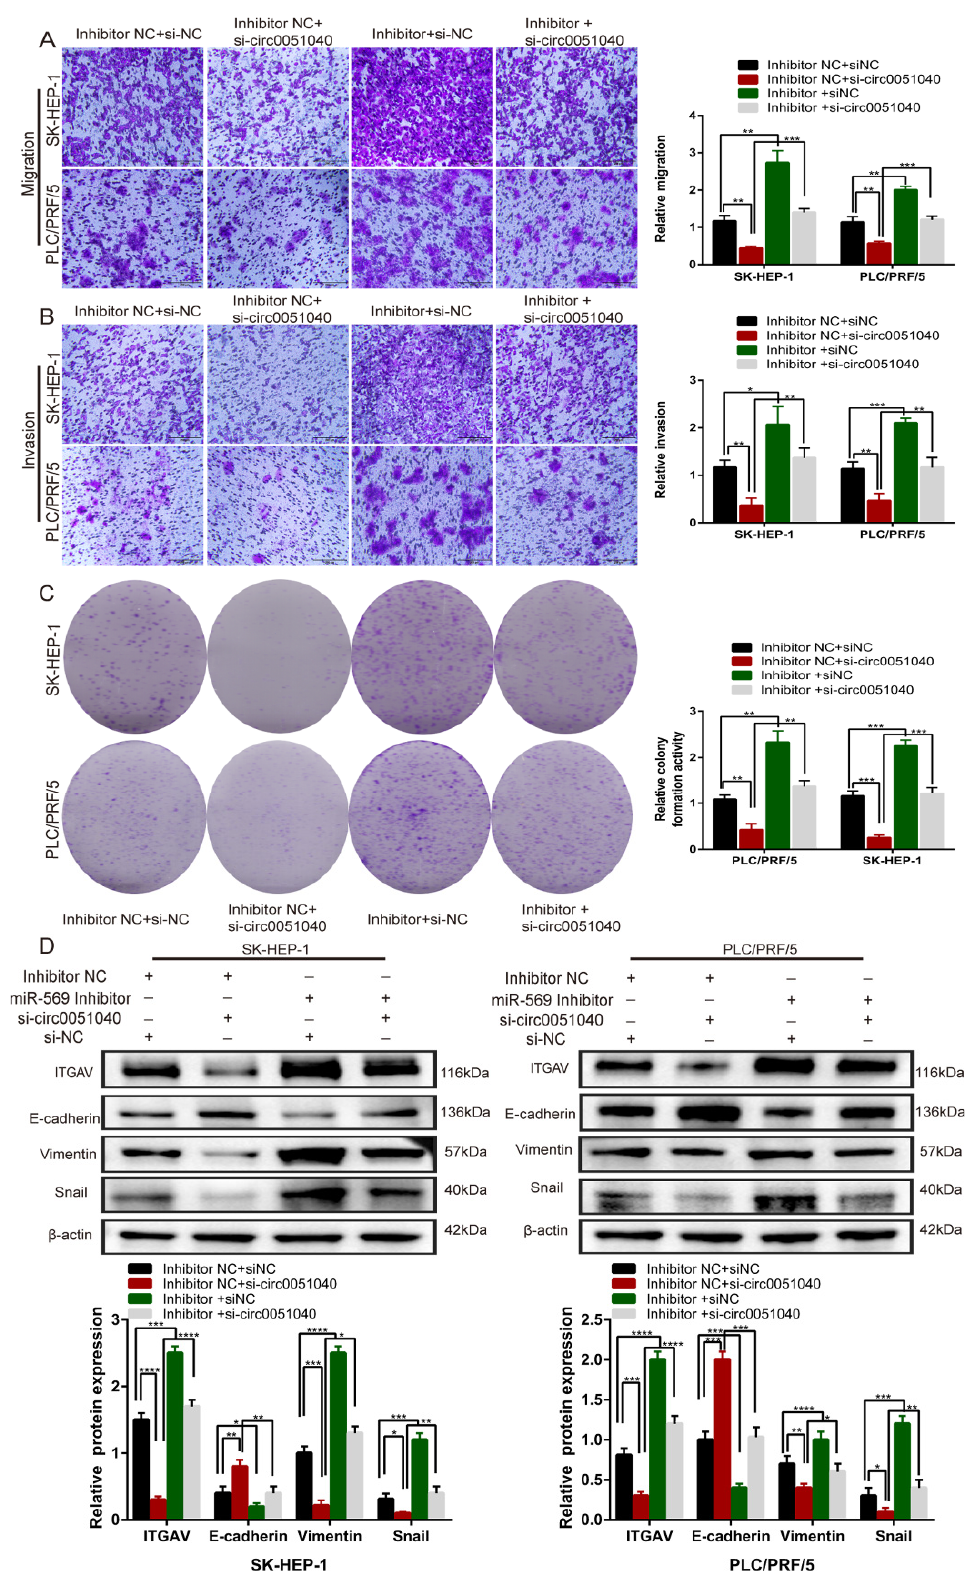
Figure 6. Hsa_circ_0051040/miR-569/ITGAV promoted EMT progression in HCC cells. ( A – C ) Repre- sentative images and quantification results of rescue migration, invasion and colony formation